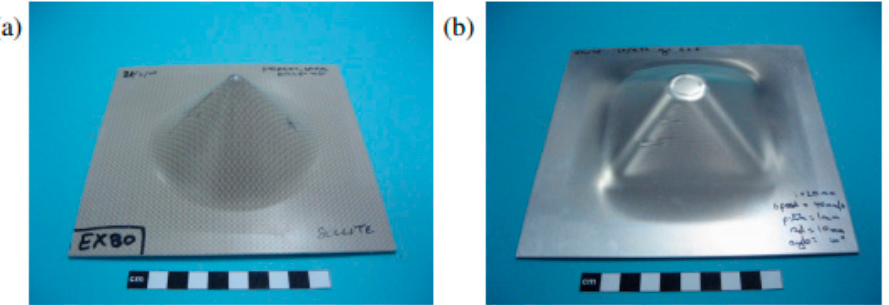
Figure 18. Sandwich panels formed using SPIF: ( a ) MS/PP/MS (45° angle without failure) and ( b ) Al/PP/Al (40° angle showing faceplate fracture) (reproduced with permission from [272]; copyright© 2021 Elsevier B.V.).